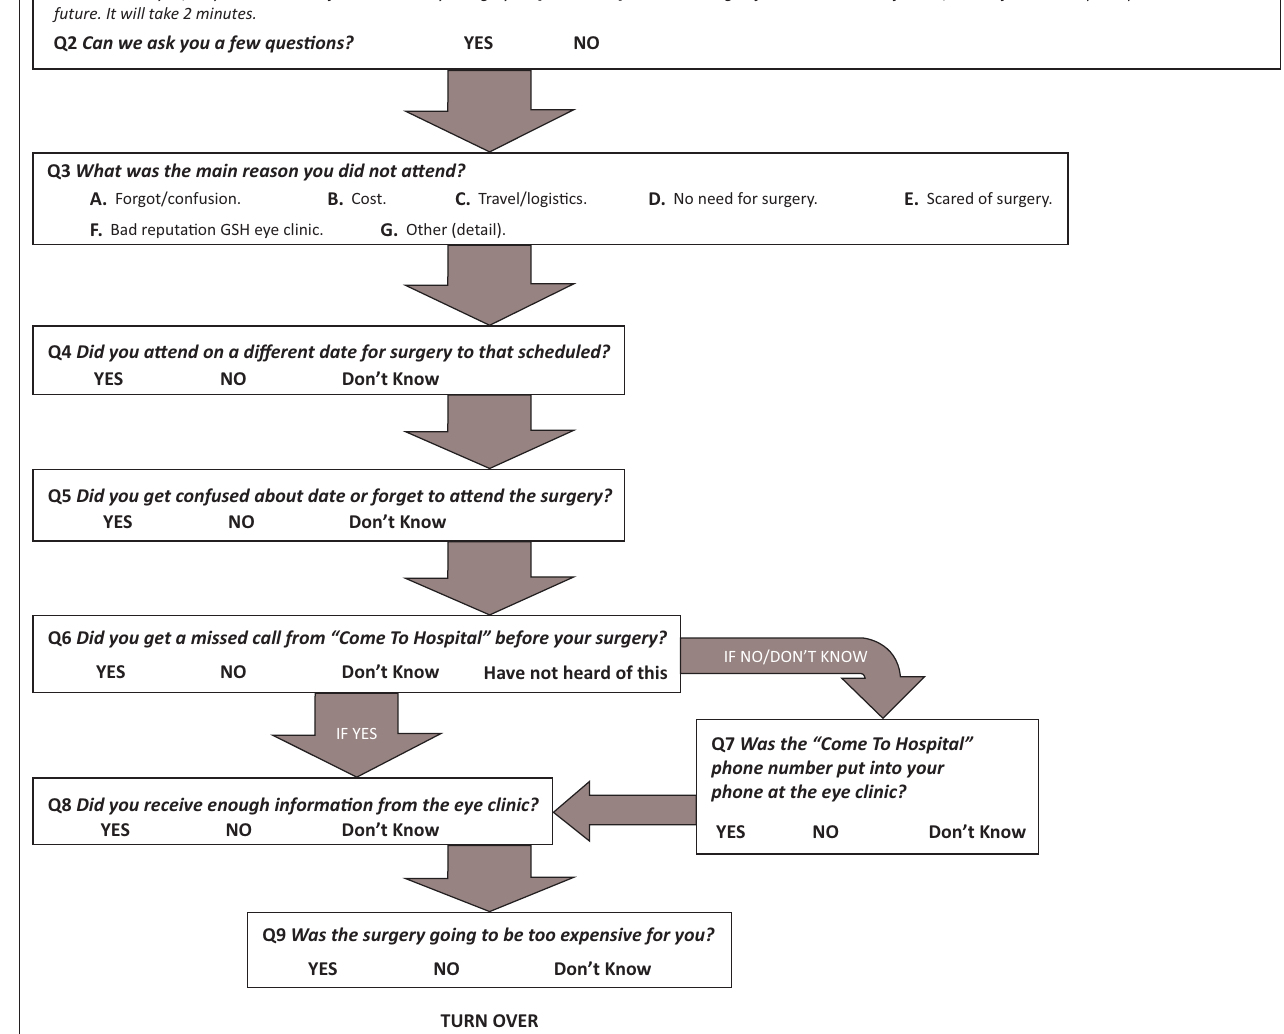
Figure 1-A1 continues on next page